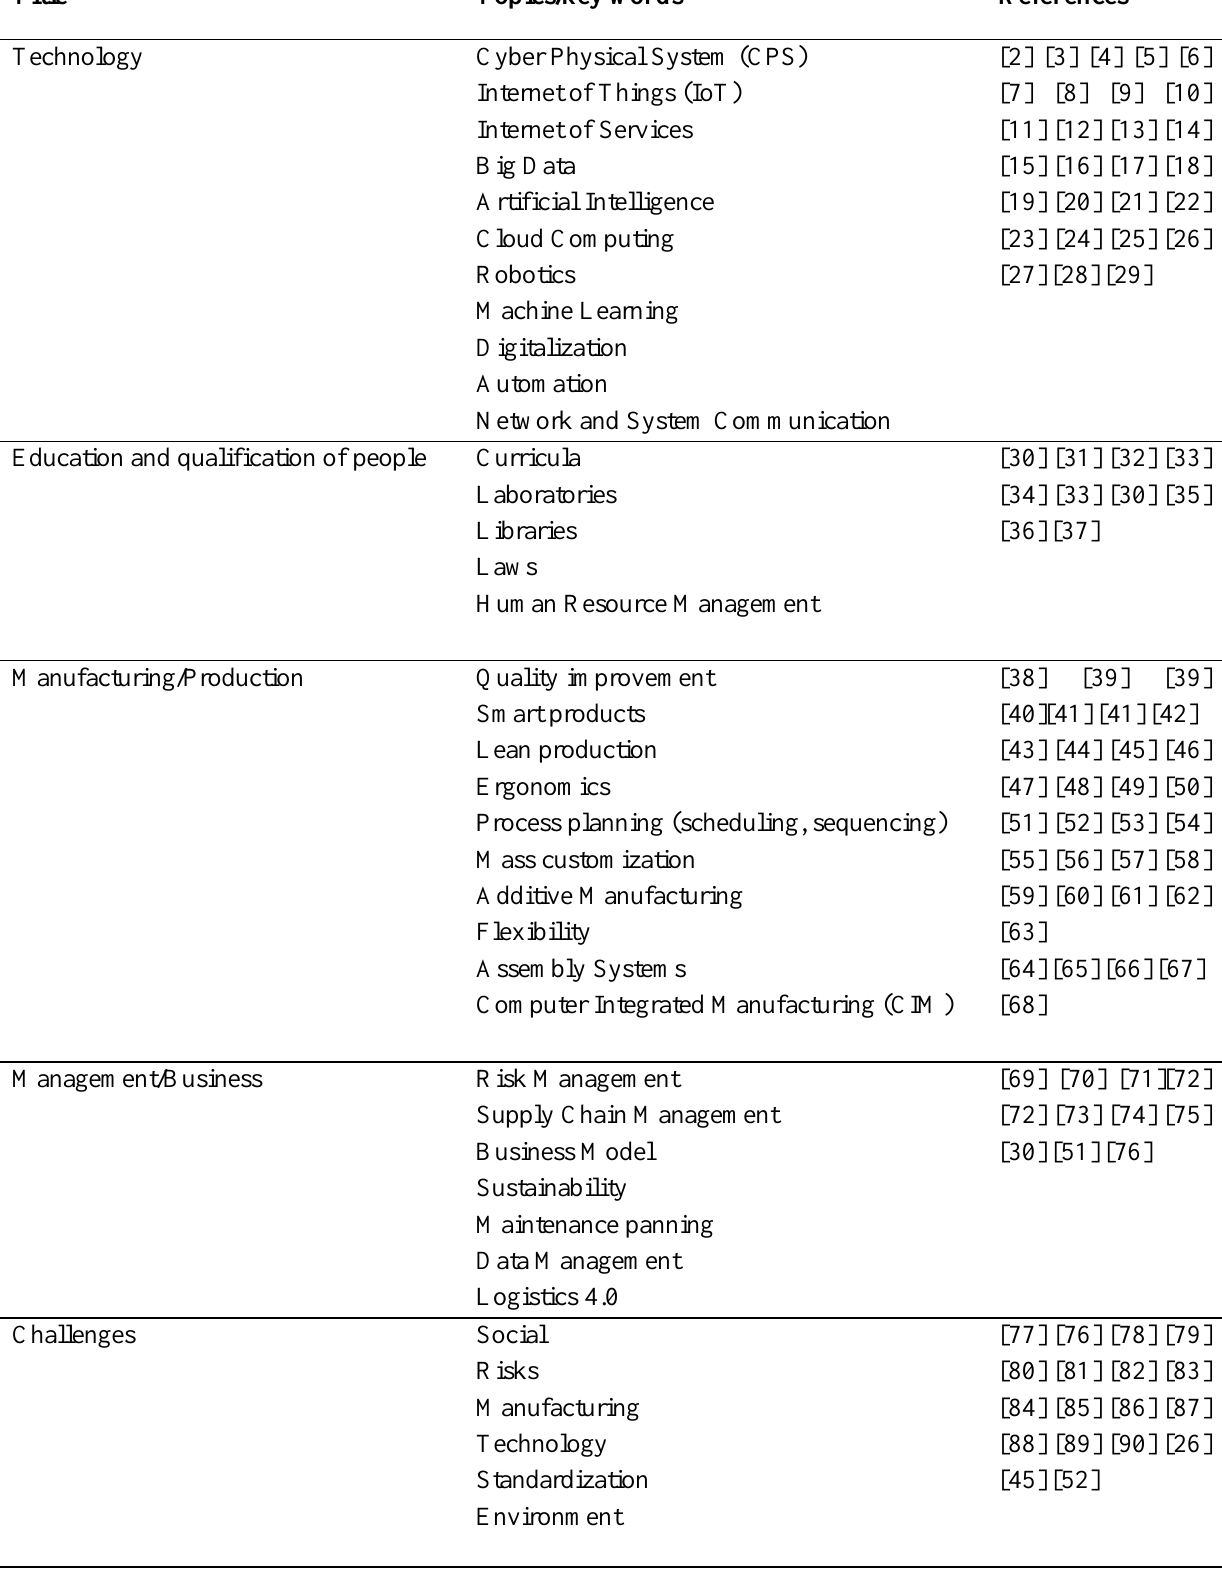
Table 1. shows the structure of the paper and briefly summarized which topics have been tackled and researched already. Table 1. Industry 4.0 topic categories discussed in the research